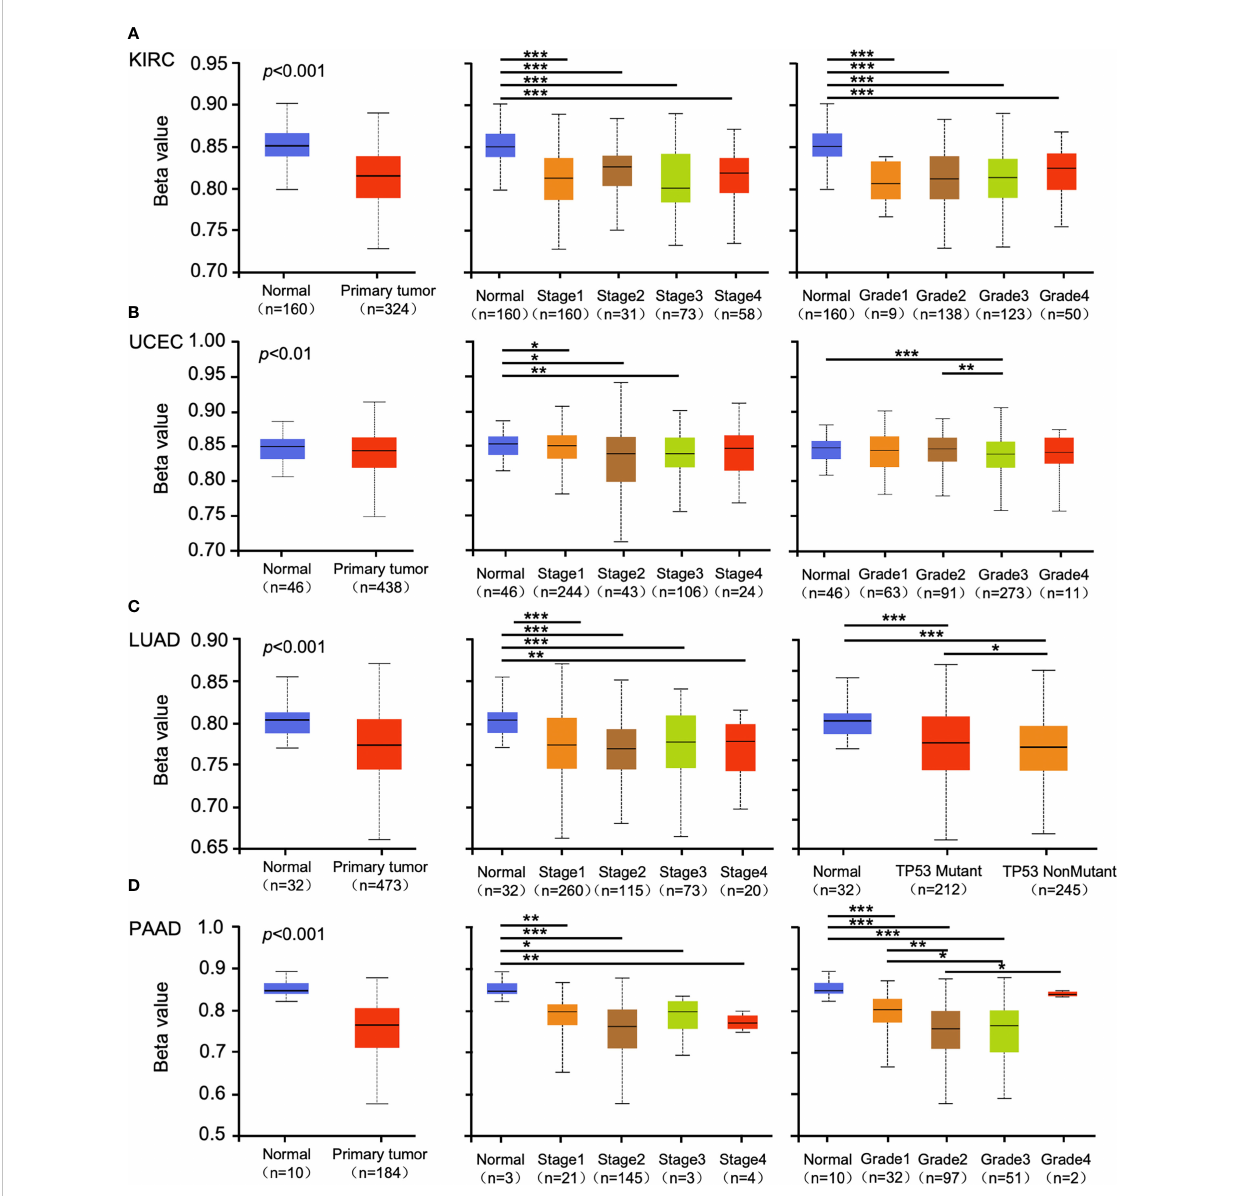
FIGURE 2 The promoter methylation level of GSDMB in different cancers. The promoter methylation of the GSDMB in KIRC (A) , UCEC (B) , LUAD (C) , and PAAD (D) with different stages, grades, and TP53 mutant pathways were analyzed through the UALCAN from the CPTAC dataset. Based on GSDMB promoter methylation pro fi les by sample types, promoter methylation levels of GSDMB were signi fi cantly reduced in KIRC, UCEC, LUAD, and PAAD primary tumors compared with normal. Based on GSDMB promoter methylation pro fi les by individual cancer stages/tumor grade, promoter methylation levels of GSDMB were signi fi cantly reduced in KIRC, UCEC, LUAD, and PAAD. The beta value indicates DNA methylation level ranging from 0 (unmethylated) to 1 (fully methylated). Different beta value cutoff has been considered to indicate hyper-methylation [beta value: 0.7 – 0.5] or hypo-methylation [beta